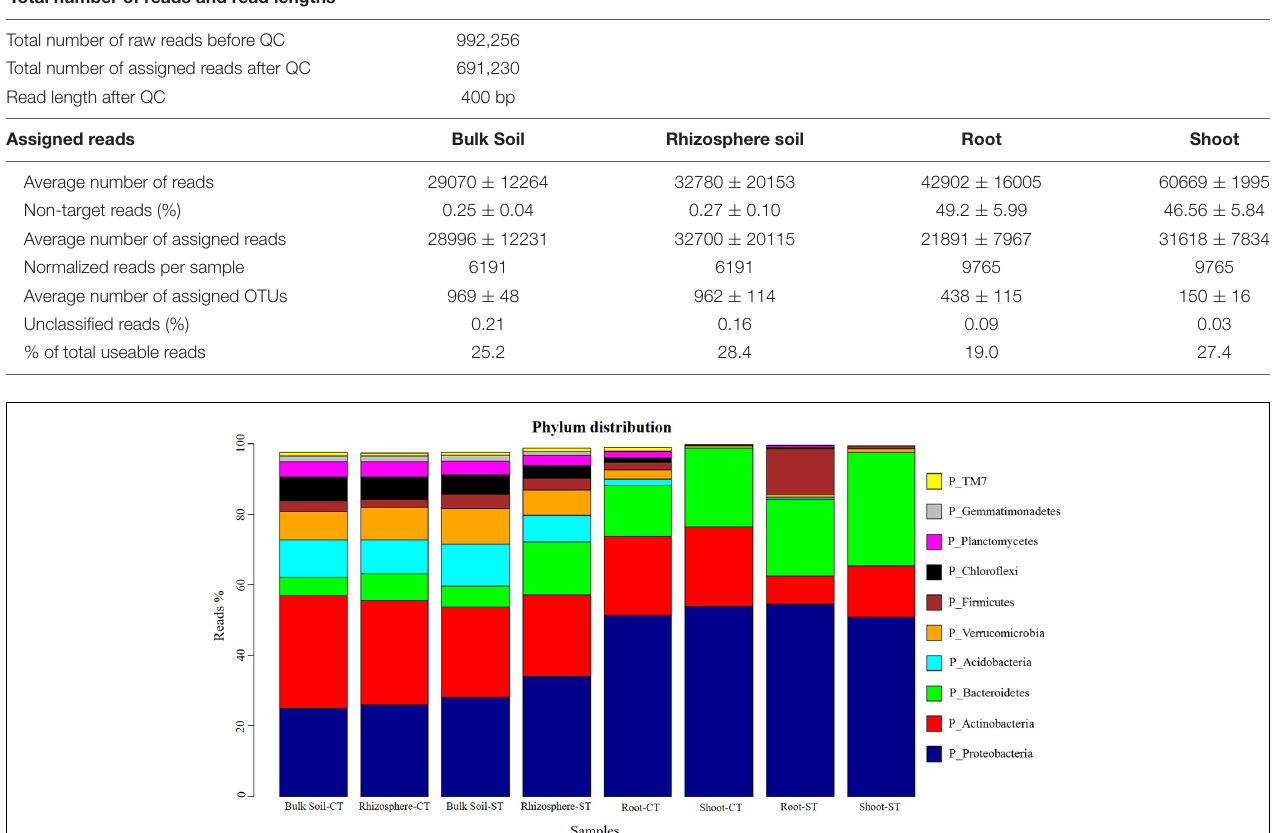
FIGURE 1 | Phylum distribution of the OTUs. Average relative abundance (% of sequencing reads) of 10 most abundant prokaryotic phyla associated with soil, rhizosphere, root and shoot microhabitat zones of WOSR under conventional tillage (CT) and conservation strip tillage (ST), are displayed in different colors. For each sample type, the number of replicates are n =